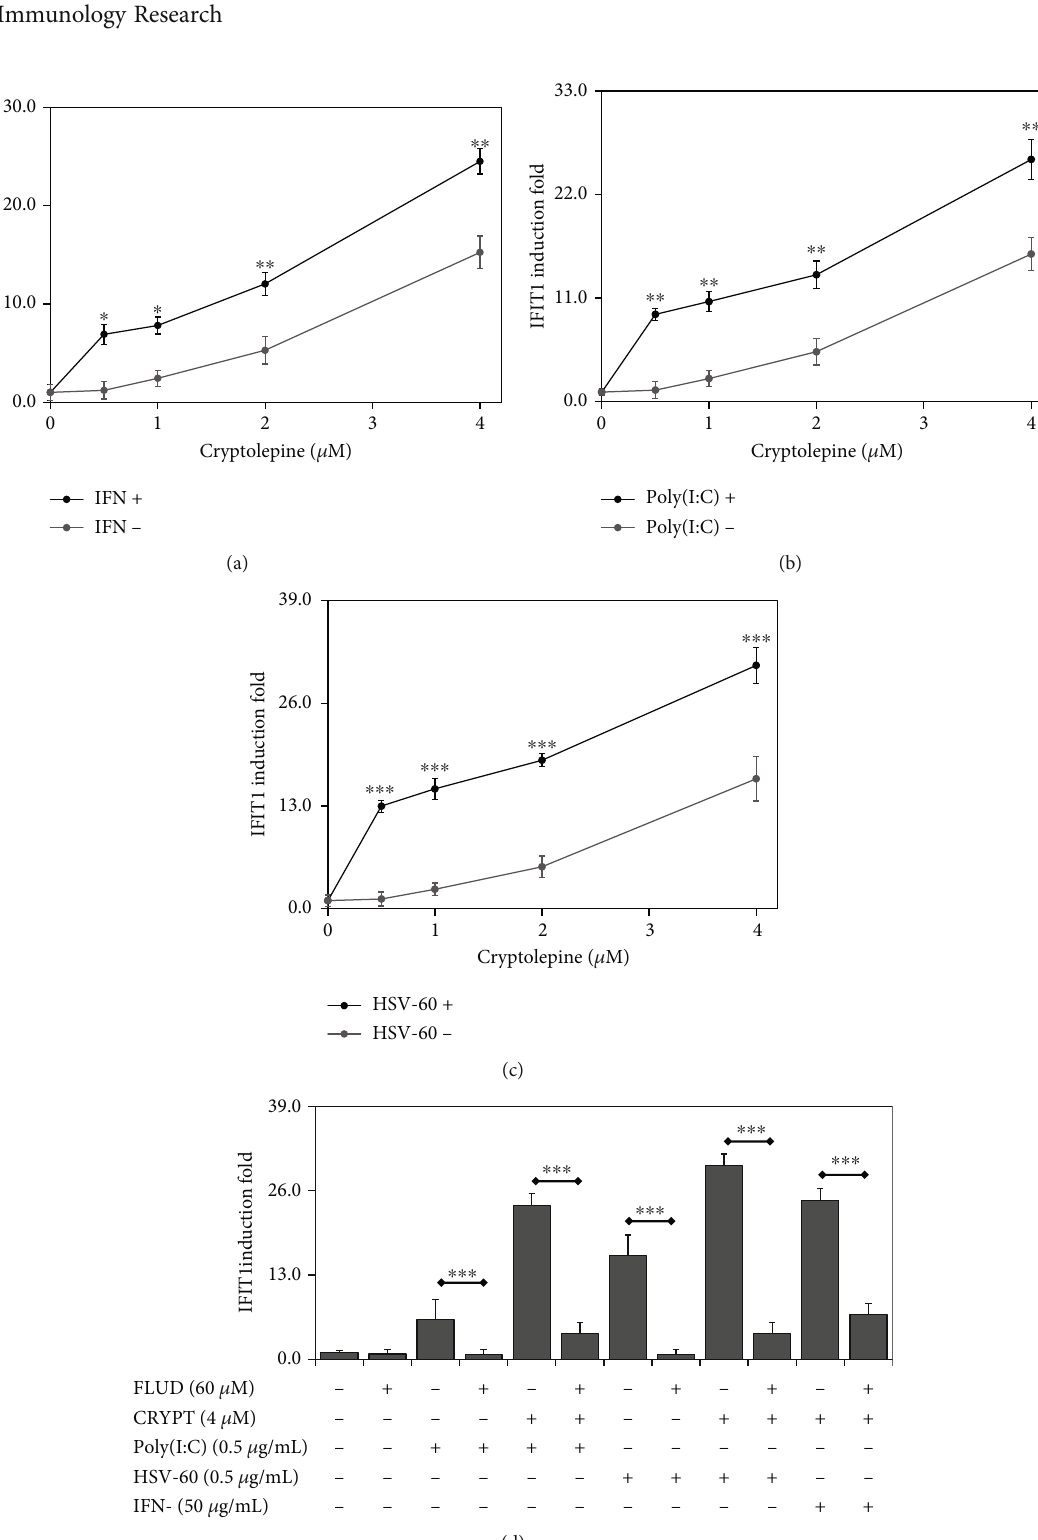
Figure 7: Cryptolepine enhances IFN-1 response activation by Poly(I:C), HSV-60, and IFN- α in THP1-derived macrophages. The derived macrophages from the parent THP1 cells were cultured with cryptolepine and 50 IU/mL IFN- α (a), 0.5 μ g/mL Poly(I:C) (b), and 0.5 μ g/mL HSV-60 (c), and the IFIT1 induction was assessed after 24 h. Moreover, the macrophages were cocultured with fl udarabine (FLUD), IFN- α (Poly(I:C) or HSV-60), and cryptolepine, and the IFIT1 induction was evaluated after 24h (d). Data are shown as the means, from three varied experiments with each done in triplicate, and error bars represent the standard deviations. ∗ p < 0 : 05 , ∗∗ p < 0 : 01 , ∗∗∗ p < 0 : 001 , and ∗∗∗∗ p < 0 : 0001 (Student ’ s t